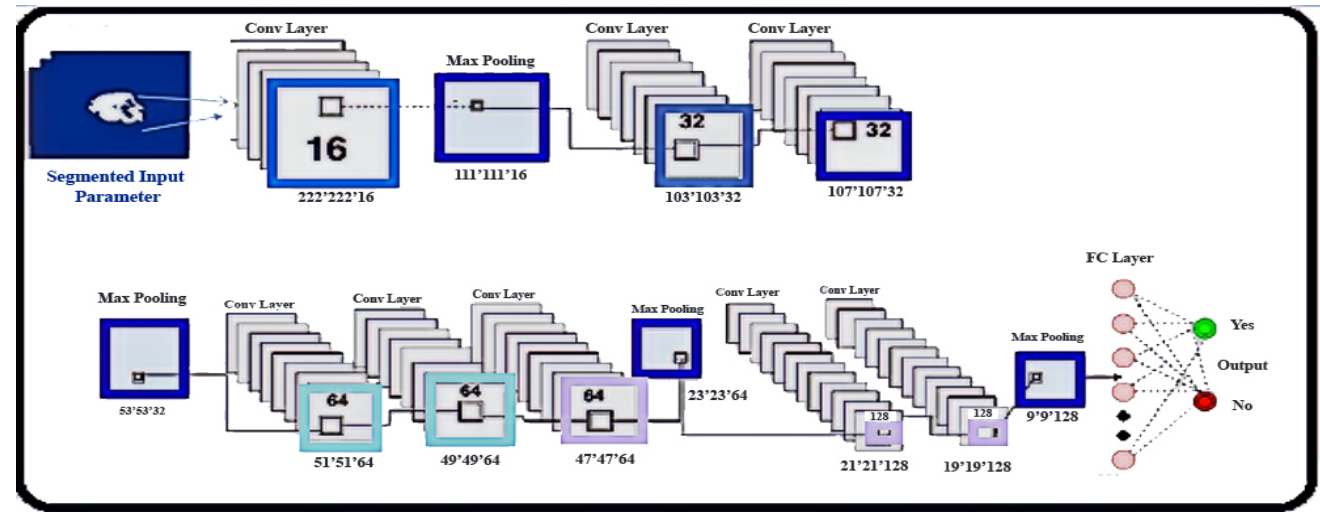
Figure 5. The framework on multigrade tumor segmentation and classification using the CNN network.